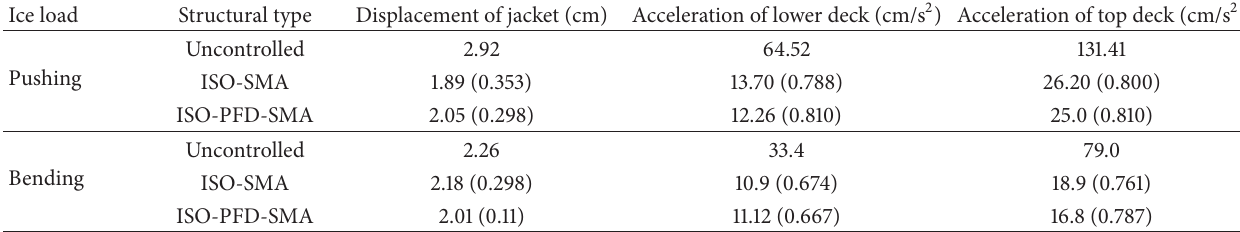
Table 6: Maximum test results of ice excitation of the